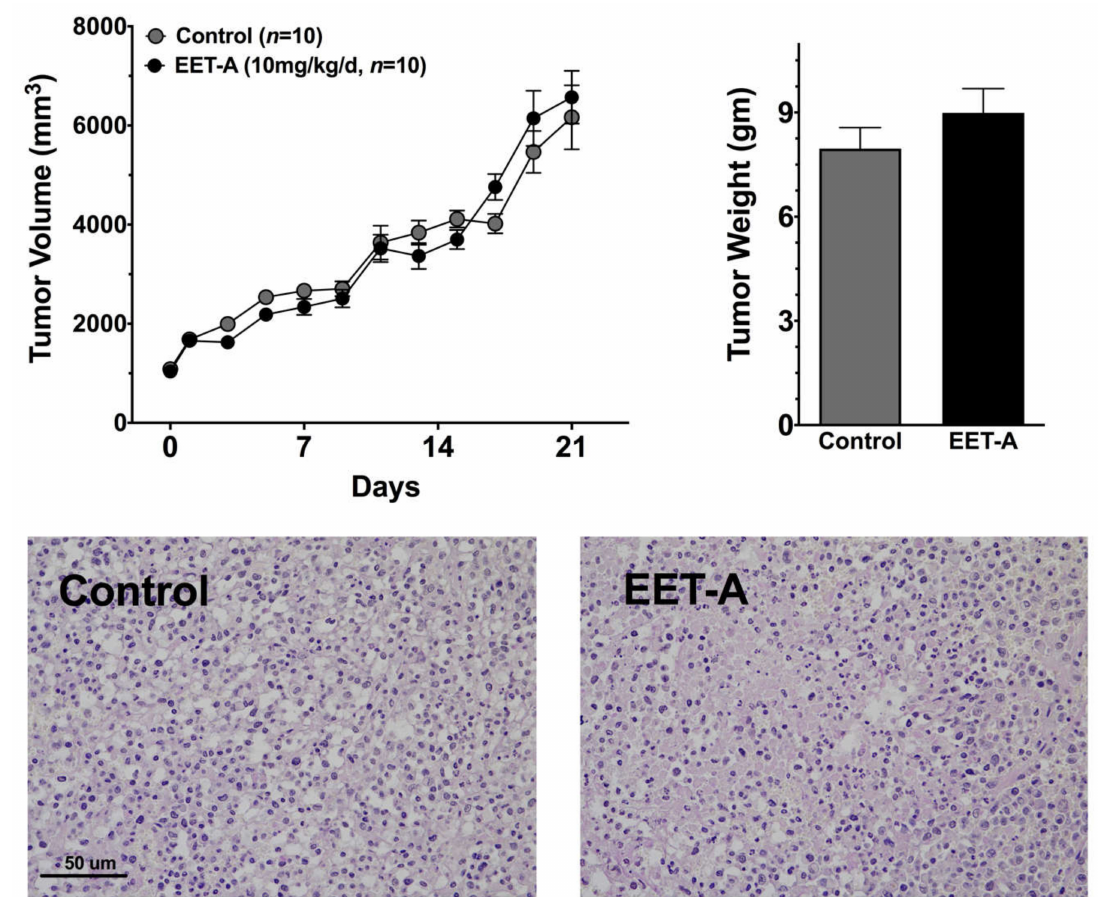
Figure 6. Tumor growth of a human breast cancer cell line, MBA-MB-231, in athymic mice is not altered by EET-A treatment. Left panel: tumor volume, Right panel: tumor weight in MBA-MB-231 tumor bearing mice treated with vehicle (control) or EET-A. Bottom panel: Representative photomicrographs of Periodic acid-Schiff (PAS) Staining depicting similar tumor hyperplasia and proliferation in human breast tumors. Data expressed as mean ± SEM, n = 5 mice and n = 10